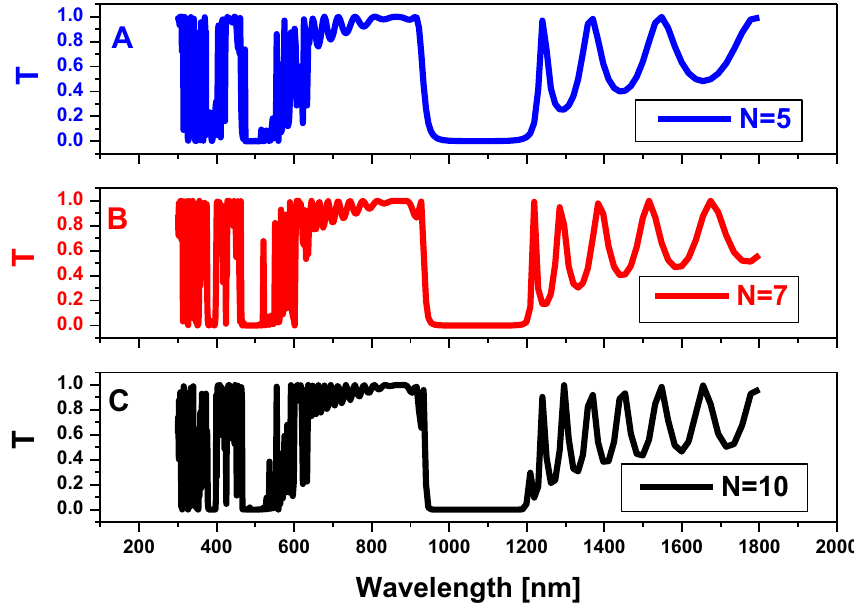
Figure 2. Transmission property of a two-dimensional hexagonal cylinder unit cell with, R = 80 nm , D = 160 nm , and all cylinders being filled with air at the host material of titanium dioxide ( TiO 2 ) with variations of number of periods as